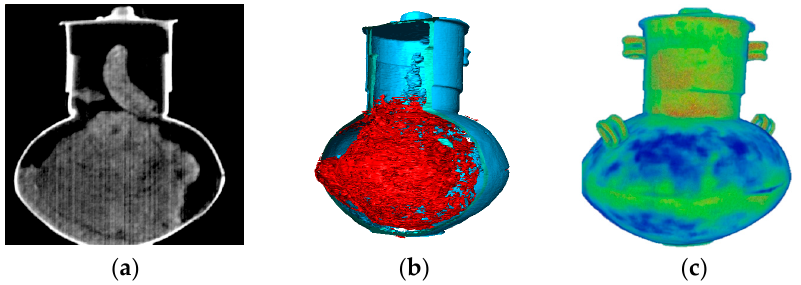
Figure 5. ( a ) The neutron radiography image of the golden vial. The bright regions correspond to high neutron attenuation in the gold component. The dark areas are the low neutron attenuation regions of the fossilized incense. The background is black. ( b ) Virtual slices of the 3D model of the studied golden vial. ( c ) The 3D model of the golden vial obtained after calculations by the Local Thickness method. A color scheme whereby the density of the neutron attenuation degree extends from low (blue) to high (red) is used.